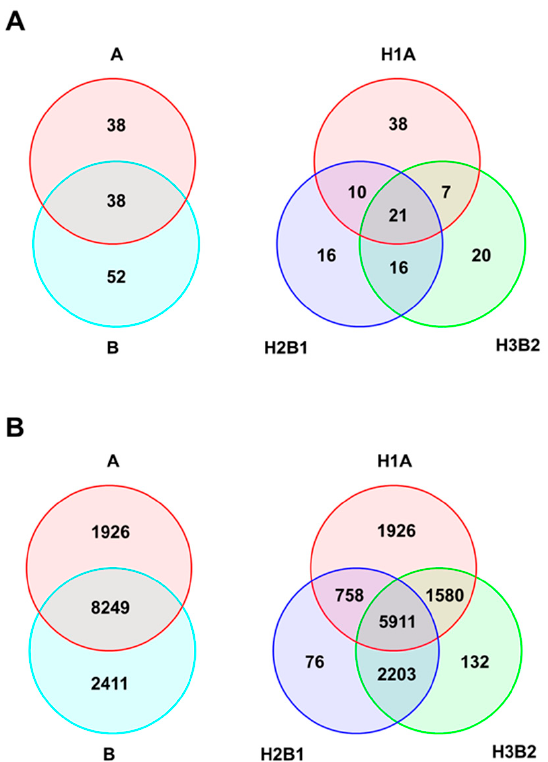
Figure 3. Venn diagrams showing distribution of ( A ) SSR and ( B ) SNP markers detected between two centres of origin (A: Mesoamerica, B: Andean) and three genetic groups (H1A, H2B1, H3B2) of true-type common bean accessions.